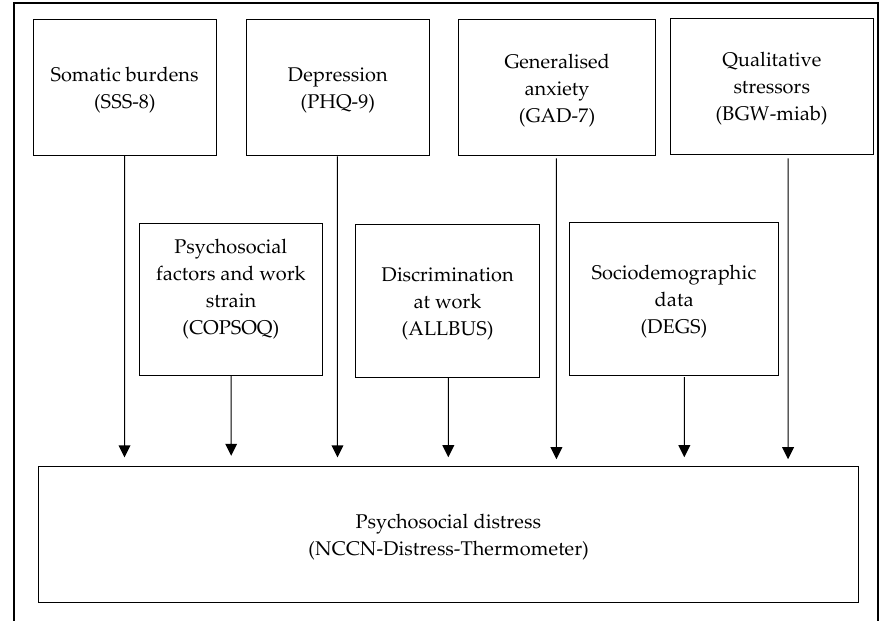
Figure 2. Flow chart of analysis. SSS-8: Somatic Symptom Scale, PHQ-9: Patient Health Questionnaire, GAD-7: Generalized Anxiety Disorder, BGW-miab: Berufsgenossenschaft für Gesundheitsdienst und Wohlfahrtspflege – Mitarbeiterbefragung, COPSOQ: Copenhagen Psychosocial Questionnaire, ALLBUS: Allgemeine Bevölkerungsumfrage der Sozialwissenschaften, DEGS: Study on Adult Health in Germany (Studie zur Gesundheit Erwachsener in Deutschland), NCCN: National Comprehensive Cancer Network Distress